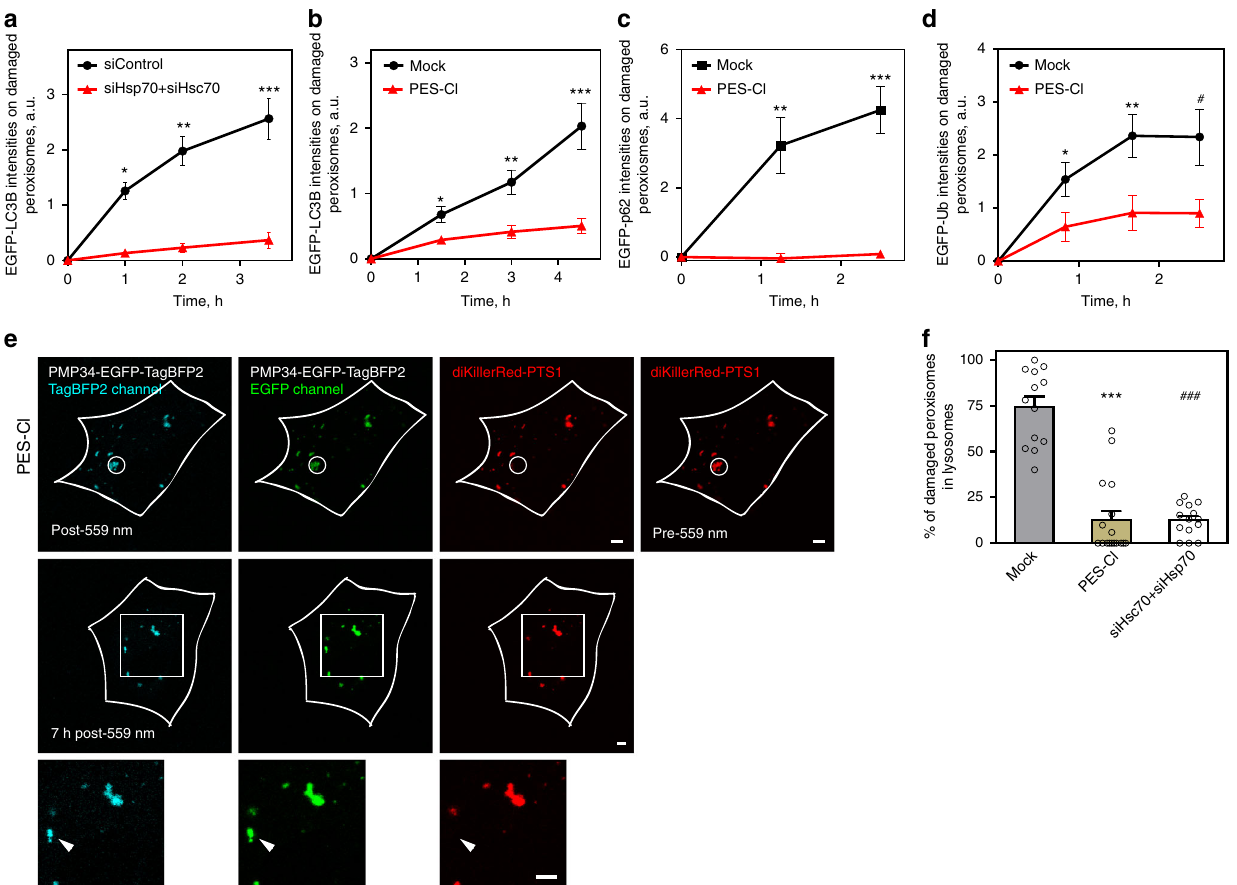
Fig. 6 Inhibiting Hsc70/Hsp70 blocks pexophagy. a Quantifying LC3B accumulation on ROS-stressed peroxisomes (as in Fig. 1h – j). Depletion of cellular Hsc70 and Hsp70 delayed LC3B appearance on ROS-stressed peroxisomes ( x -axis represents time after 559 nm illumination; siControl, n = 8 cells; siHsp70 + siHsc70, n = 18 cells). * P = 4.25E − 09, ** P = 8.32E − 09, *** P = 3.22E − 07 (one-tailed t test). b Hsp70/Hsc70 inhibition on LC3B accumulation. Treating cells with PES-Cl delayed LC3B appearance on ROS-stressed peroxisomes (Mock, n = 10 cells; PES-Cl, n = 14 cells). * P = 0.0011, ** P = 0.0004, and *** P = 3.89E − 05 (one-tailed t test). c Inhibiting Hsc70/Hsp70 with PES-Cl delayed EGFP-p62 accumulation on ROS-stressed peroxisomes (Mock, n = 9 cells; PES-Cl, n = 10 cells). ** P = 0.0018 and *** P = 0.0001 (one-tailed t test). d PES-Cl treatment delayed EGFP-Ub accumulation on ROS-stressed peroxisomes (Mock, n = 11 cells; PES-Cl, n = 15 cells). * P = 0.0227, ** P = 0.0046, and # P = 0.0071 (one-tailed t test). All error bars in a – d represent mean ± SEM. e Same experimental setup as Fig. 2a, b, but with PES-Cl treatment. Peroxisomes within the white circular region in a NIH3T3 cell expressing PMP34-EGFP-TagBFP2 and diKillerRed-PTS1 were illuminated with 559 nm light (top panels). The EGFP and TagBFP2 signals of 559 nm illuminated peroxisomes were monitored 7 h after illumination (middle panels). The white arrows indicate that EGFP fl uorescence persisted on ROS-stressed peroxisomes (bottom panels; magni fi ed view of the white square region in middle panels). f The percentage of peroxisomes that entered